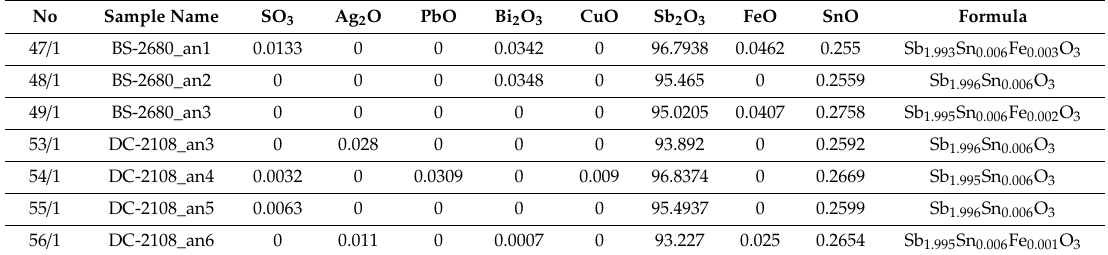
Table 1. Electron Probe Microanalyzer (EPMA) results for valentinite from Baia Sprie and Dealul Crucii deposits.